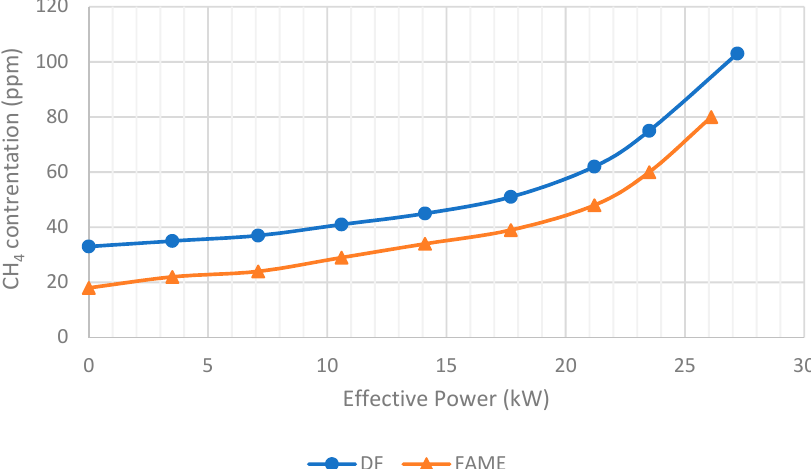
Figure 10. CH 4 emission level in the exhaust as a function of the effective power of the S-4003 engine, at an engine speed of 1600 rpm.